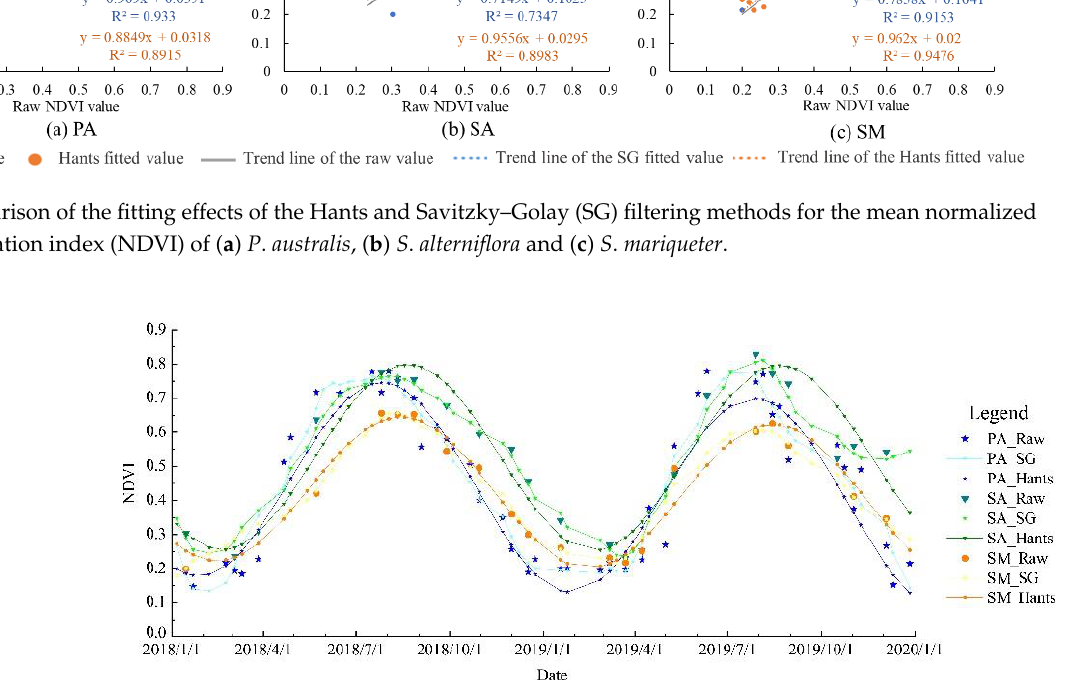
Figure 4. Comparison of Hants and SG filtering methods used to extract wetland vegetation phenology